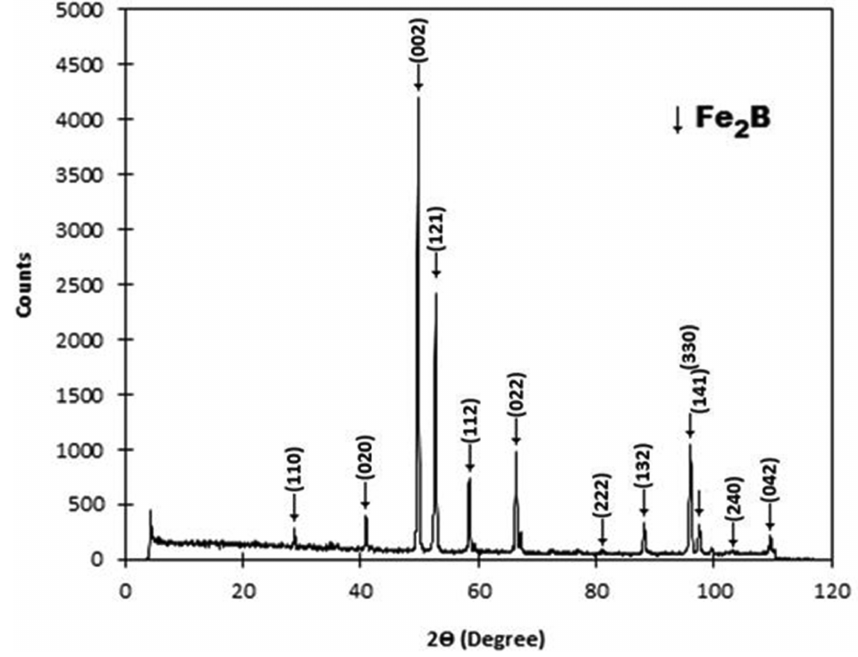
Figure 4: XRD pattern obtained at the surface of the borided AISI 1518 steel at 1273 K for 8 h.